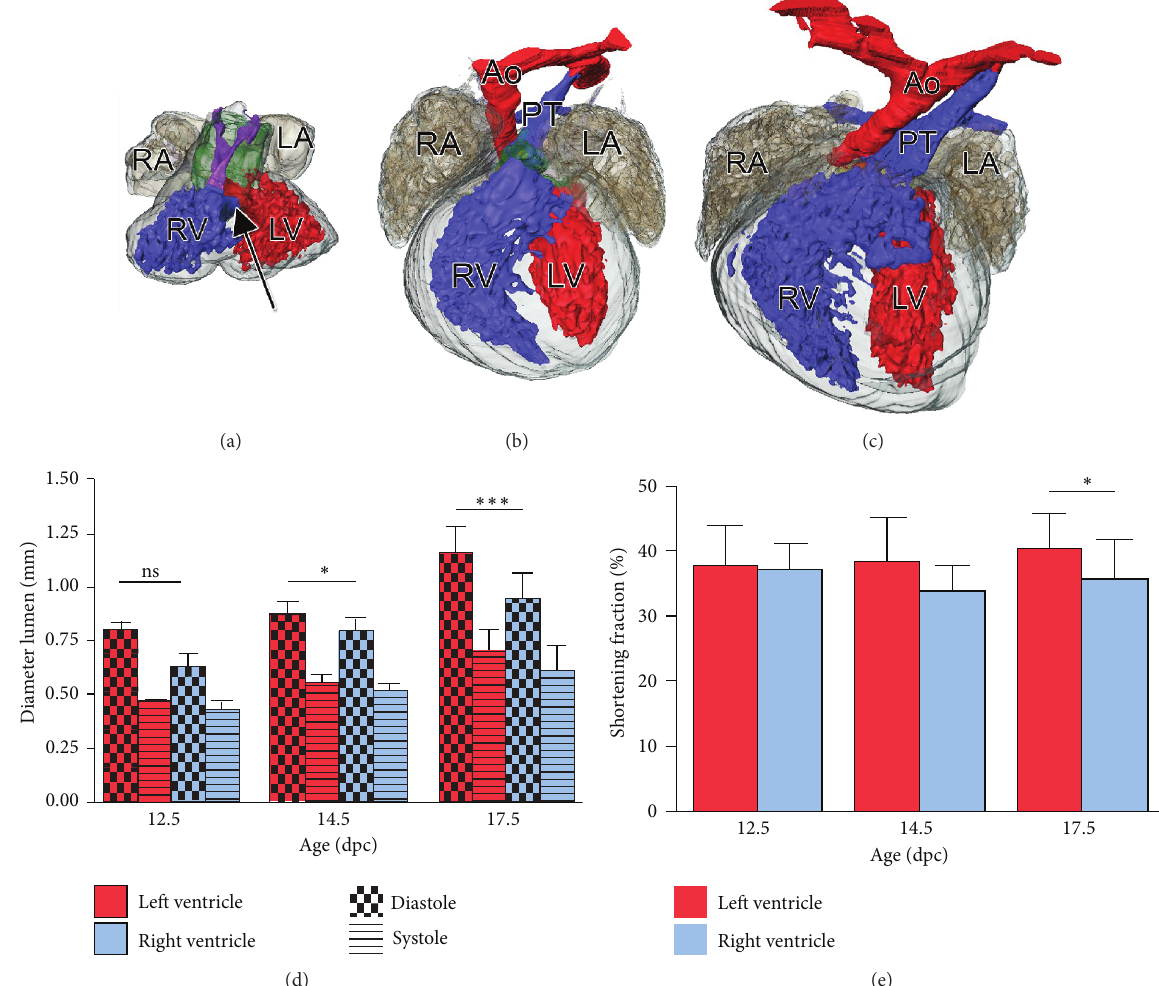
Figure 2: Cardiac morphology and FS% calculation. (a) Shows a reconstruction of the anterior view of an embryonic heart of 12.5 dpc. The myocardium is indicated in grey transparent. The LA and RA are indicated in transparent dark grey. The LV and RV lumen are indicated in red and blue, respectively. Note that the outflow tract lumen (purple) is positioned completely above the future RV, which is surrounded by large outflow tract cushions (green transparent). At these stages development of the IVS has not yet completed leading to a direct connection between the LV and RV via the interventricular foramen (arrow). (b) Anterior view of an early fetal heart of 14.5 dpc. At this stage IVS development has been completed and four separate cardiac chambers can be identified. The outflow tract consists of a separate Ao and PT including their valve apparatus, which at these stages mainly consist of cushion tissue (green transparent). (c) Anterior view of a late fetal heart of 17.5dpc. At this stage the heart shows a mature morphological phenotype. (d) Schematic representation of LV and RV diameters and (e) FS% at the three consecutive stages of